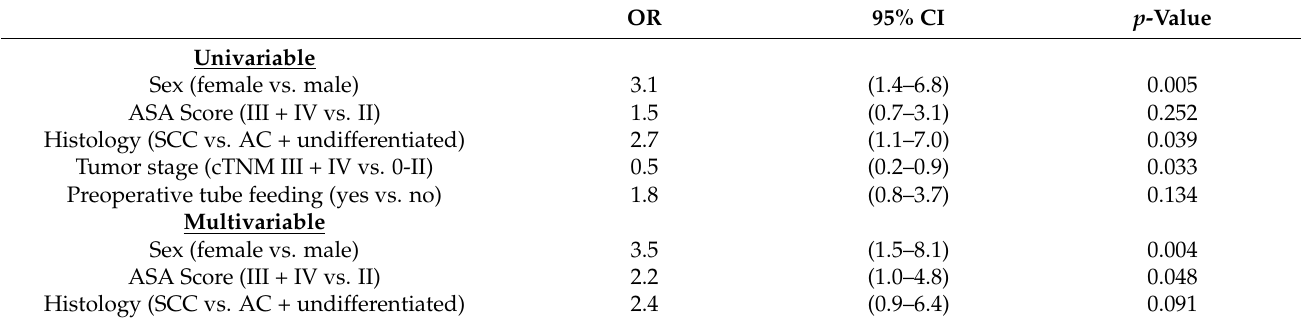
Table 2. Univariable and multivariable regression for nutritional protocol deviation for any cause. OR 95% CI p